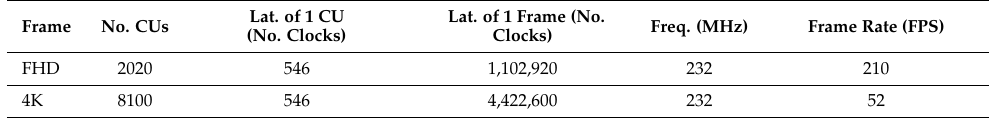
Table 4. Frame Rate of the FHD and 4K Video.